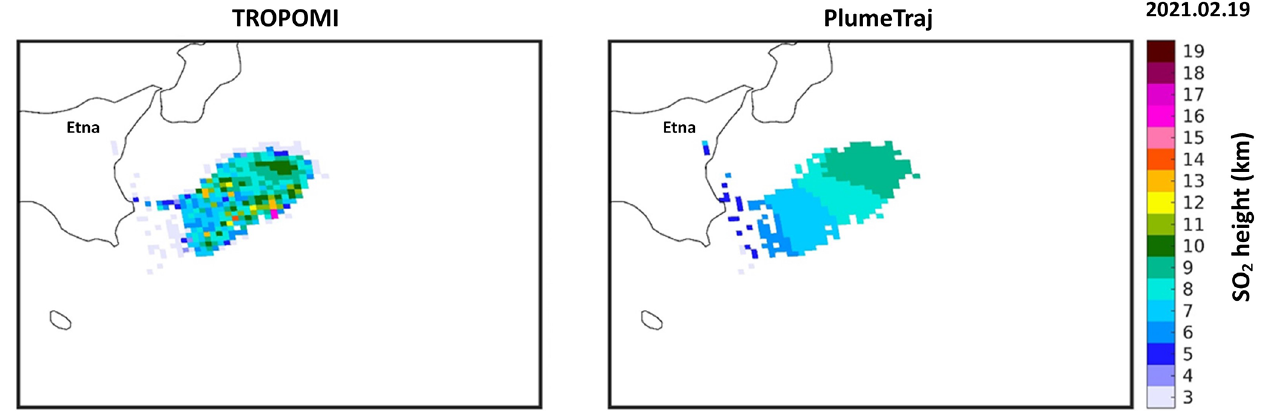
Figure 6. Example of SO 2 height results derived from TROPOMI and PlumeTraj for an Etna plume on 19 February